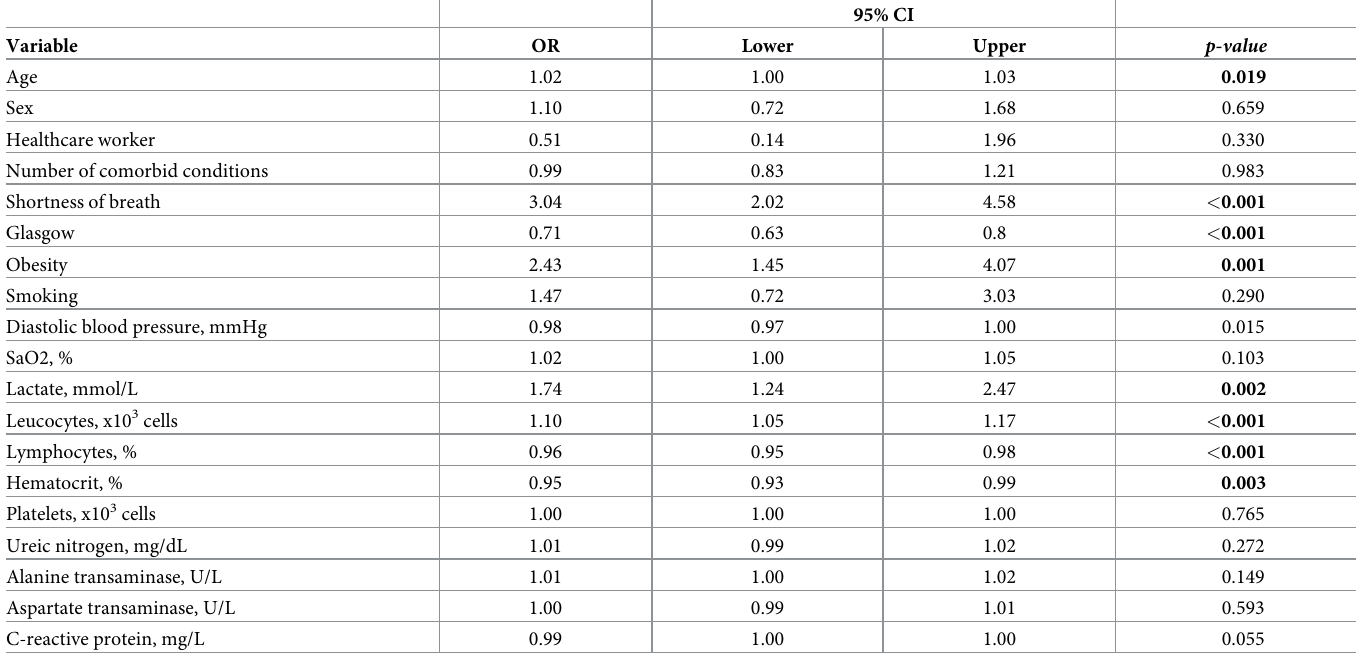
This study describes the clinical characteristics, systemic complications, and outcomes from a prospective, multinational cohort of hospitalized patients diagnosed with COVID-19 from eight countries in Latin America. In our cohort, we found that age, shortness of breath, obesity, Table 3. Logistic binary multivariate analysis fitted to assess the factors associated with admission to the intensive unit (ICU). 95% CI